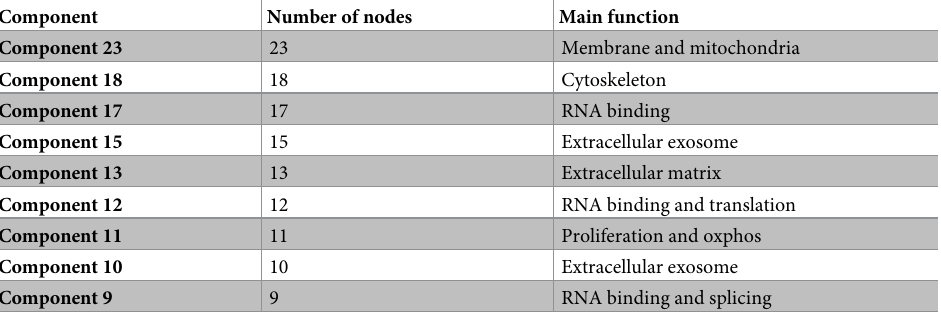
Table 2. Features of components obtained by DAG